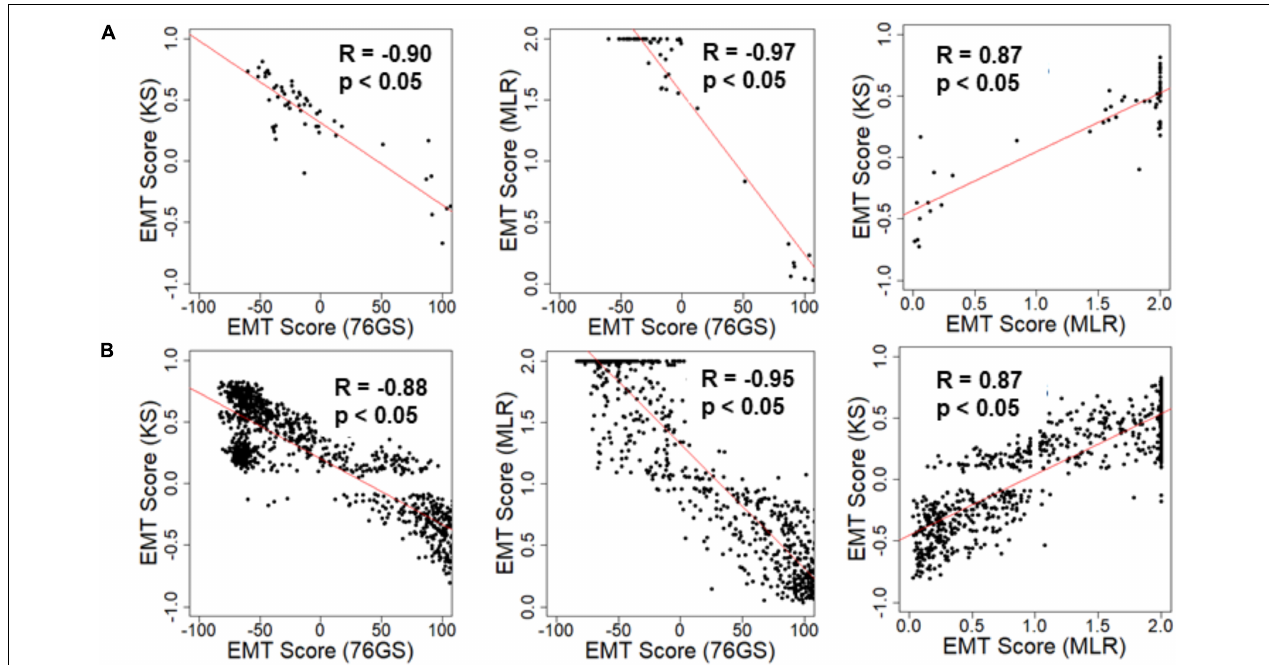
FIGURE 2 | Scatter plot depicting the correlation between the EMT scores of cancer cell line samples calculated via three methods. Each pairwise relation is estimated by a linear regression line (red), Pearson’s correlation coefficient ( R ), and p -value ( p ) reported in each plot. (A) NCI60 dataset and (B) CCLE